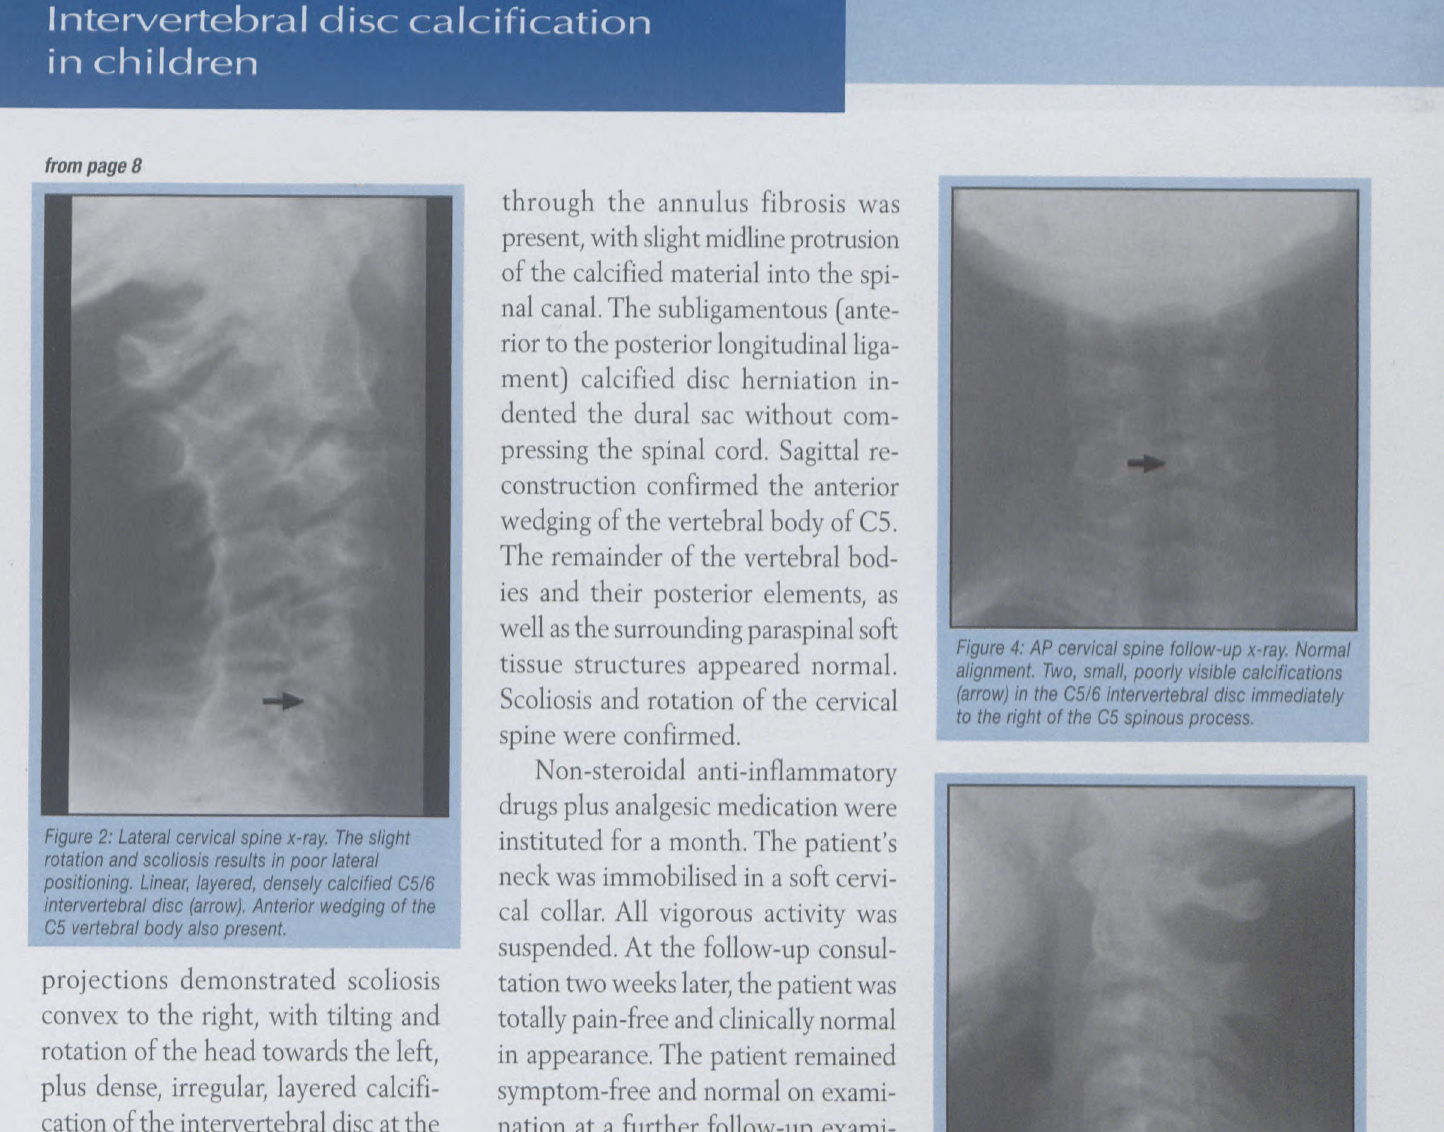
Figure 5: Lateral cervical spine fol/ow-up view. Normal alignment. Multiple, poorly visible, small calcifications (arrow) scattered in the CS/6 Intervertebral disc. Anterior wedging of the CS vertebral body stil/